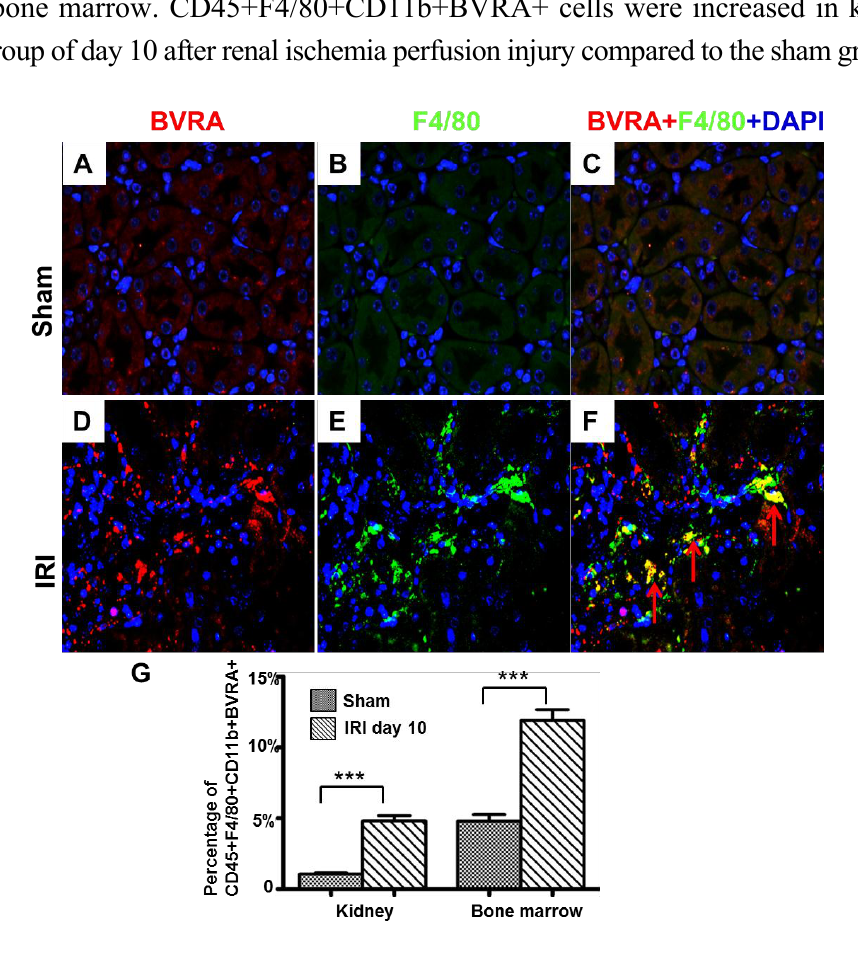
Figure 6. BVRA positive macrophages existed in mice renal ischemia reperfusion injury. Paraffin embedded sham mice renal tissue showed BVRA staining in red ( A ), F4/80 staining of macrophages in green ( B ) and DAPI counterstain in blue. BVRA positive macrophages were merged in yellow ( C ); Paraffin embedded mice ischemia reperfusion injury renal tissue showed BVRA staining in red ( D ); F4/80 staining of macrophages in green ( E ) and DAPI counterstain in blue. BVRA positive macrophages were merged in yellow ( F ) (red arrow). Original magnification 800 ×; ( G ) Representative CD45+F4/80+CD11b+BVRA